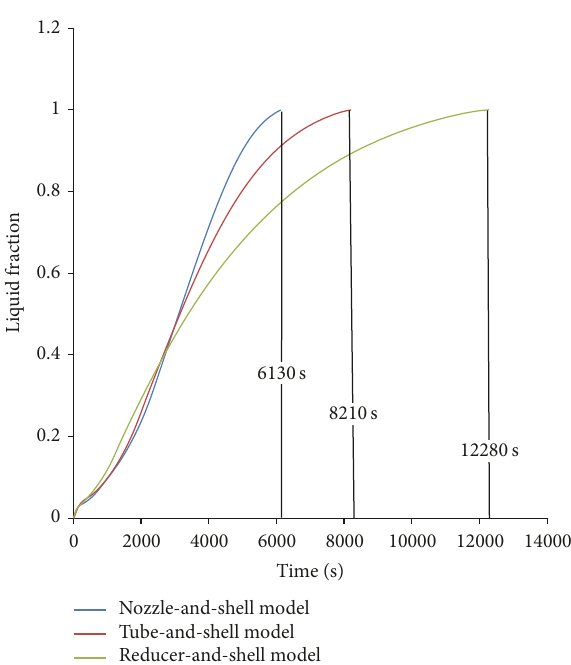
Figure 9: The comparison of liquid fraction.